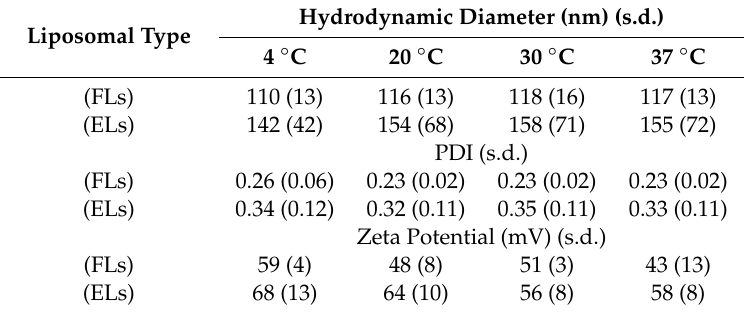
Table 1. Temperature dependence of the hydrodynamic diameter, polydispersity index (PDI), and zeta potential of fusogenic (DOPE/DOTAP/TFPE-head 1/1/0.1 mol/mol) (FLs) and endocytic (DOPC/DOTAP/TFPE-head 1/1/0.1 mol/mol) (ELs) liposomes. Experiments are performed in a PBS buffer at physiological pH 7.4. Given are averages over three independent measurements and, in parentheses, their standard deviations.